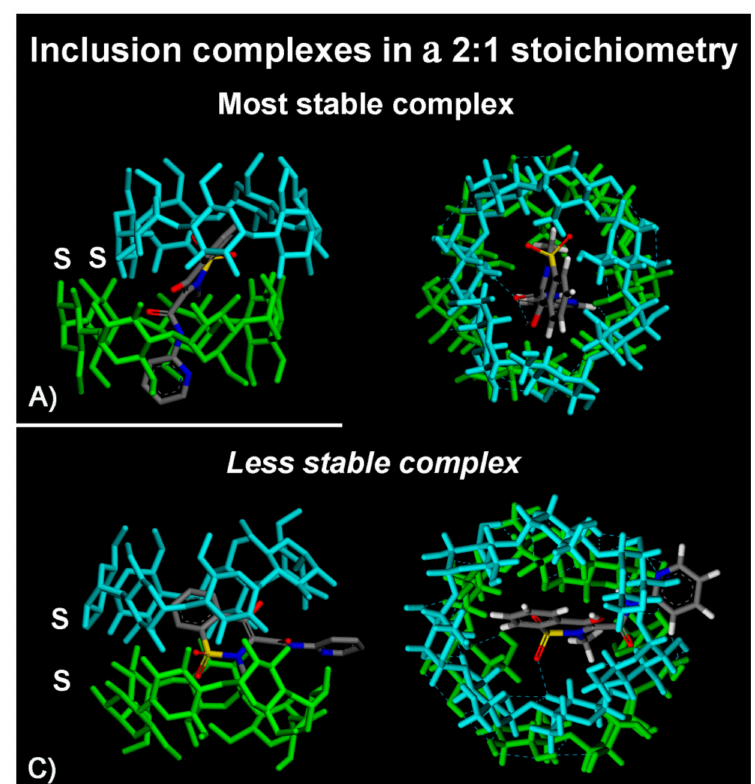
Figure 4. The side view (left) and the top view with H-bonds (light blue dotted lines) (right) of the 2:1 host–guest complexes formed by PX with two β -CDs, ( A ) in the most stable and ( C ) in the less stable optimized geometries found after the MD runs. The β -CD of the first 1:1 complex is in green, the second one facing the secondary rim is in light blue. The piroxicam molecule is colored by atoms. Color codes: C atoms are grey, O atoms are red, N atoms are blue, S atoms are yellow. In the side view, the H atoms are omitted for clarity.